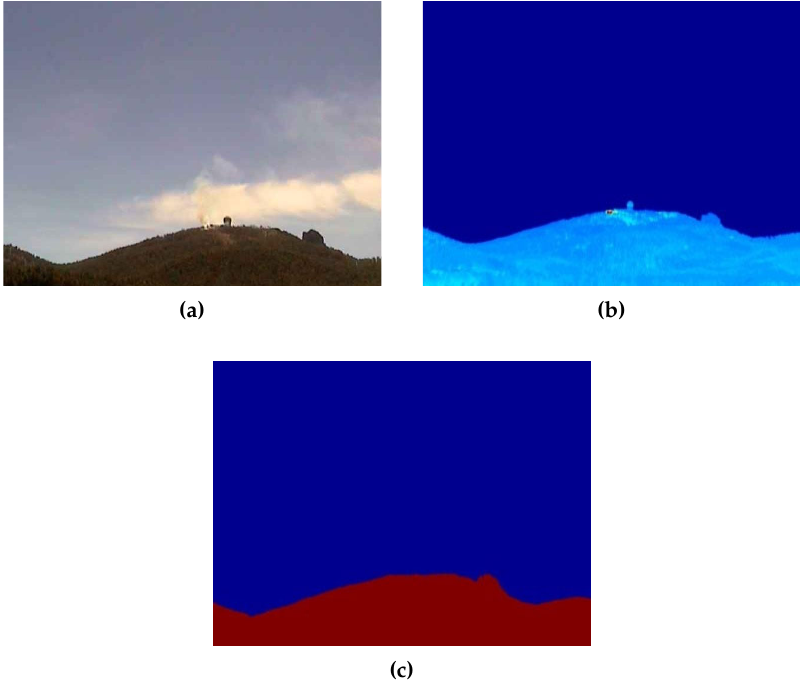
Figure 11. Set of images produced by the RDMU during nominal operation. ( a ) Visible channel. ( b ) Thermographic image. ( c ) Synthetic